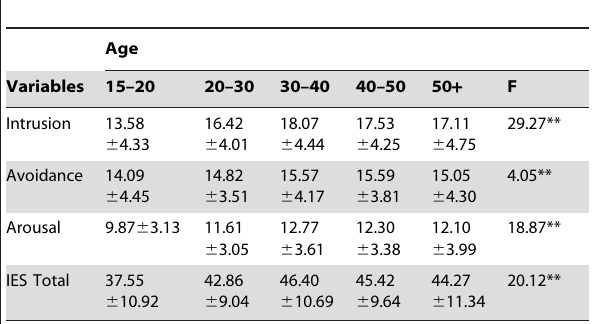
Table 3. Age group differences in